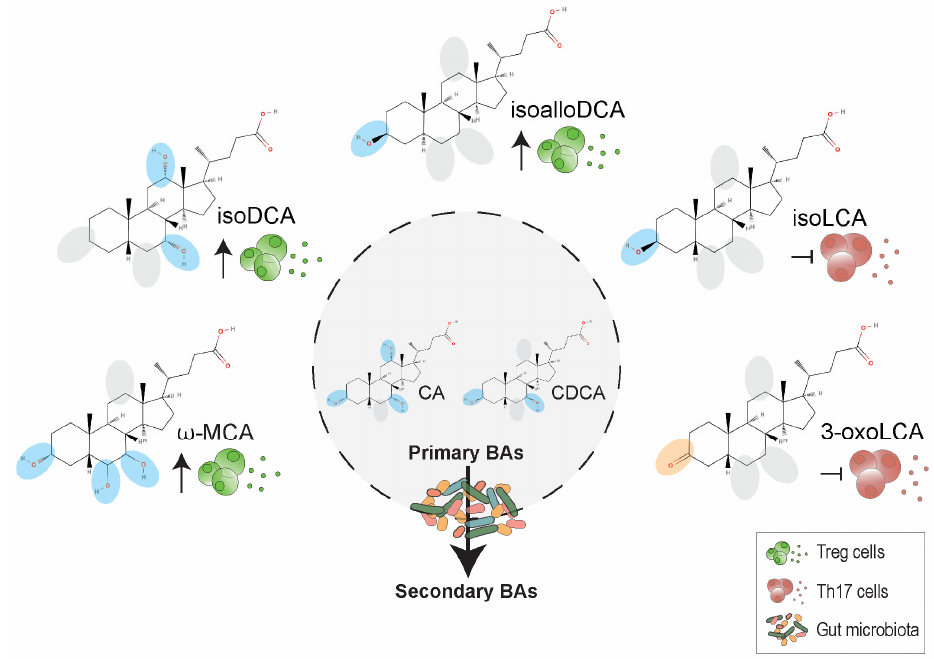
Figure 4. Secondary bile acids have immunoregulatory and antiinflammatory effects on T cell populations. Primary bile acids (BAs), such as cholic acid (CA) and chenodeoxycholic acid (CDCA), are transformed into secondary BAs by the gut microbiota. Only a few secondary BAs have been proven to exert immunoregulatory (increase of regulatory T cell populations) or antiinflammatory (inhibition of proinflammatory T helper 17 cells) effects among the overall set of secondary BAs (more than 20). For visualization purposes, hydroxyl radicals are highlighted in blue color, carbonyl group in orange color, and the absence of radical in grey color. Abbreviations: BA: bile acid; CA: cholic acid; CDCA: chenodeoxycholic acid; DCA: 3 α ,12-dihydroxy-5 β -cholan-24-oic acid; LCA: lithocholic acid; MCA: muricholic acid.